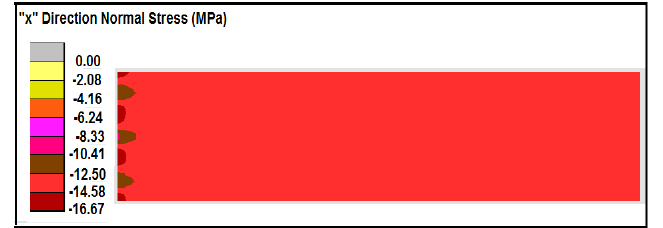
Figure 16. Field of the normal stresses on the mass of concrete: Day 860 – Case